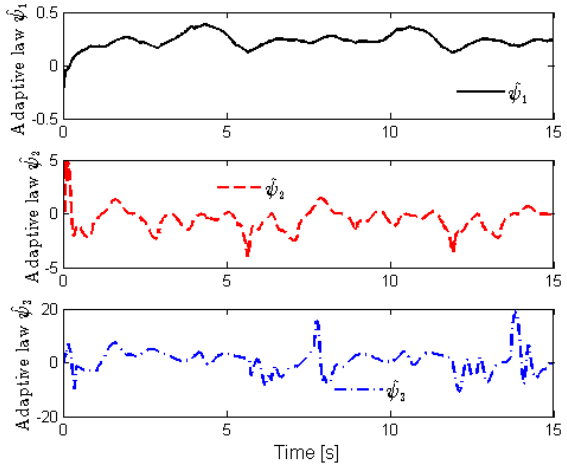
ψ ( 1,2,3 i = ). ψ ( 1,2,3 i = ). i i